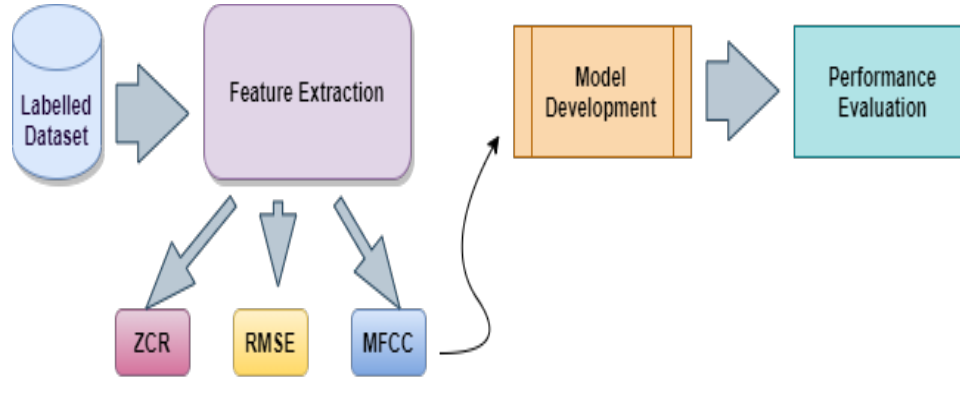
Figure 1. Proposed